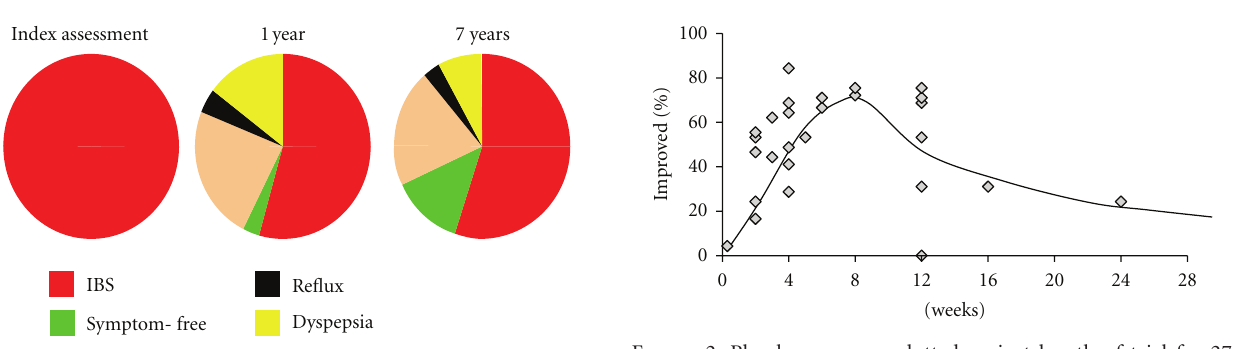
Figure 2: Placebo response plotted against length of trial for 27 randomised controlled trials performed during 1976–1998. There are not enough data points between 3–6 months, but it appears that the placebo response increases and then decreases with time, peaking at 8 weeks. Modified from